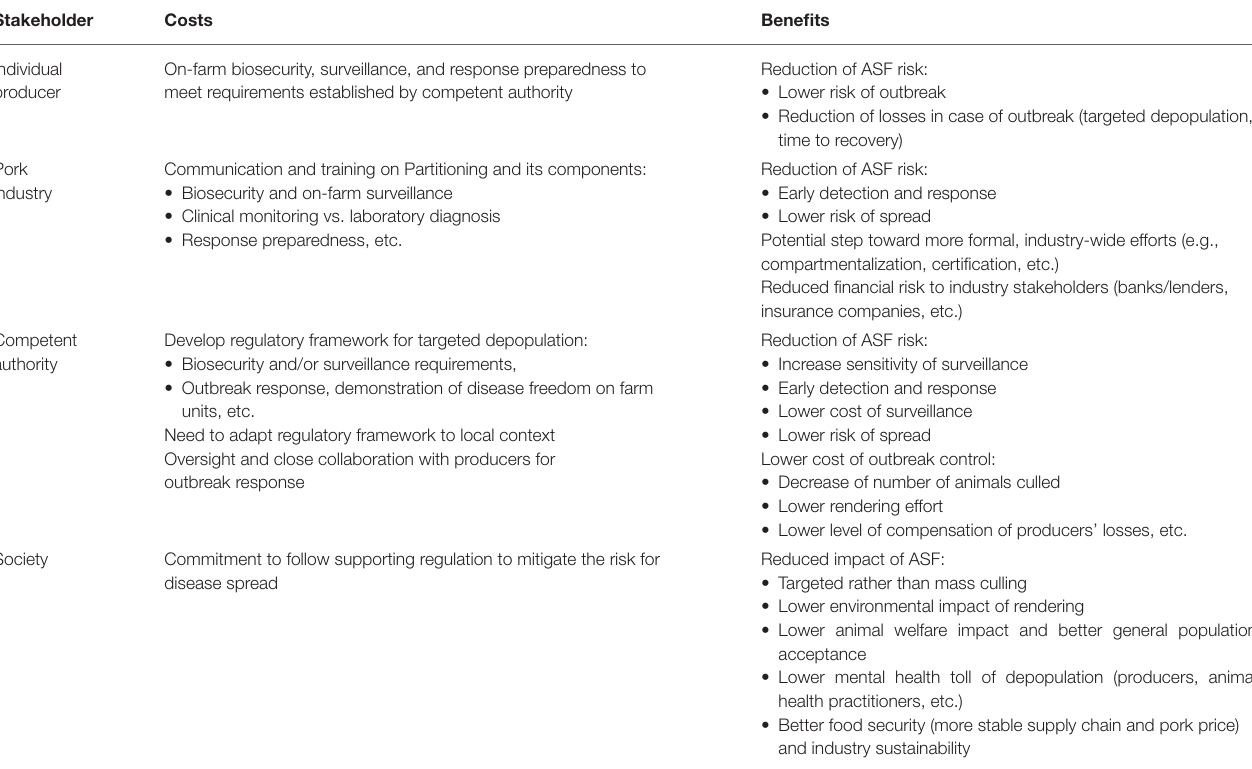
TABLE 1 | Anticipated costs and benefits of partitioning for different